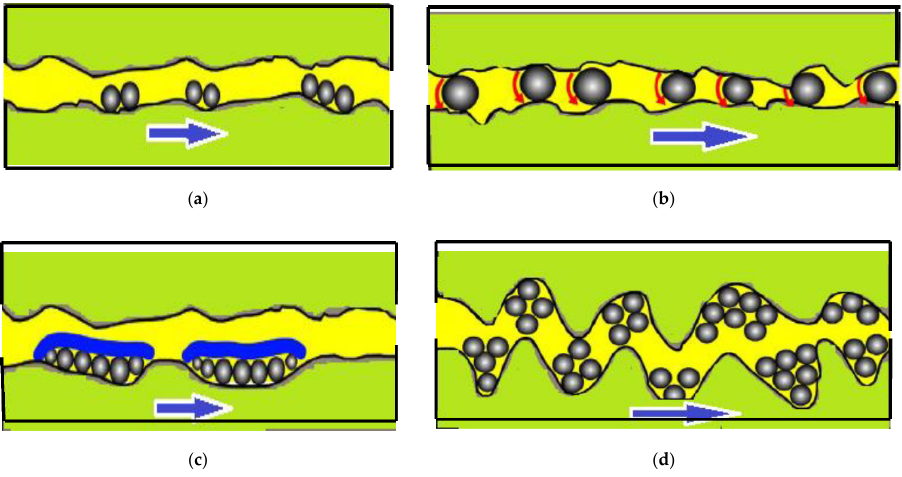
Figure 10. Schematic illustration of different lubrication mechanisms of nanoparticles [288]. ( a ) Pol- ishing mechanism, ( b ) rolling mechanism, ( c ) self-repairing mechanism, ( d ) tribo-film mechanism.